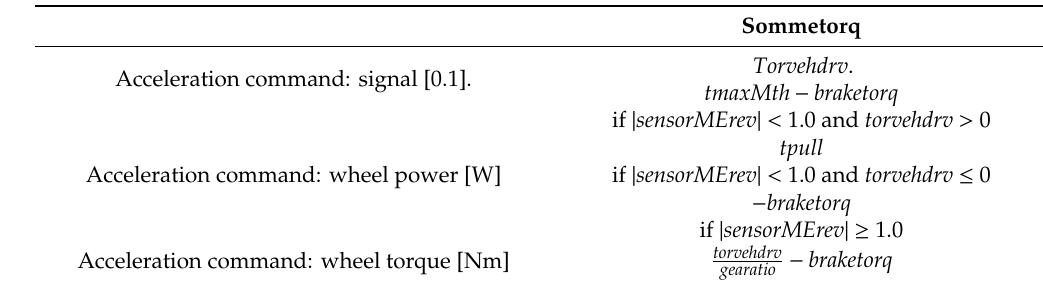
Table 11. Torque